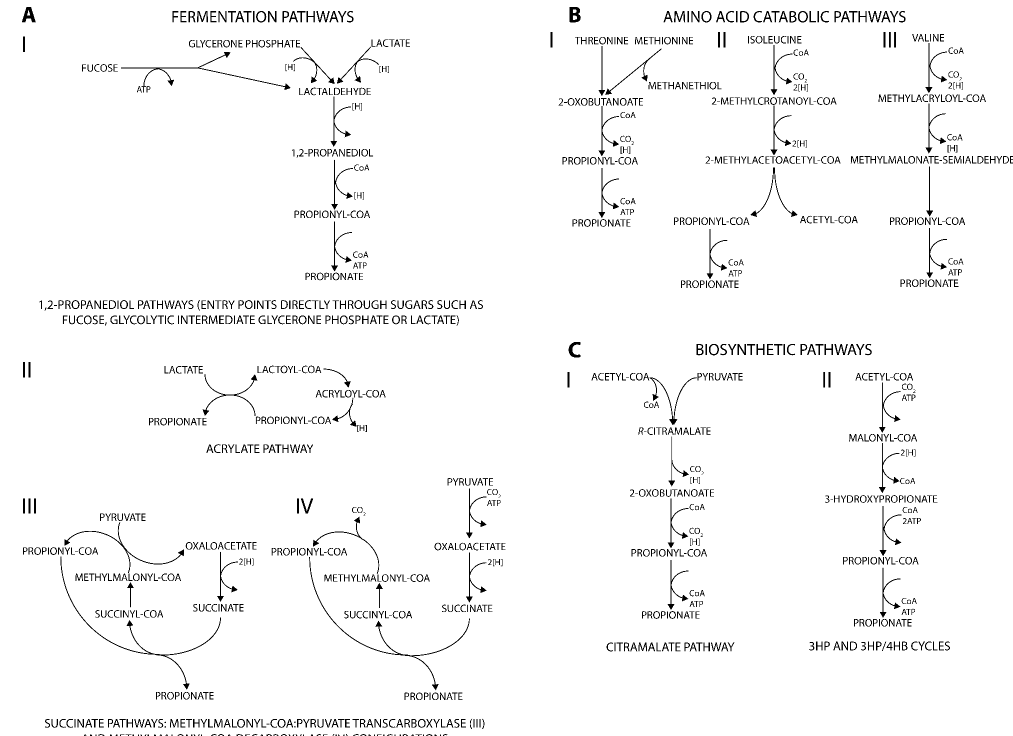
Figure 1. Metabolic pathways allowing the synthesis of propionate. A : Fermentation pathways (I-propanediol pathways, II-acrylate pathway, III-Wood-Werkman cycle, IV-sodium-pumping); B : Amino acid catabolic pathways (I-threonine and methionine catabolism, II-isoleucine catabolism, III-valine catabolism); C : Biosynthetic pathways (I-citramalate pathway, II-3-hydroxypropanoate